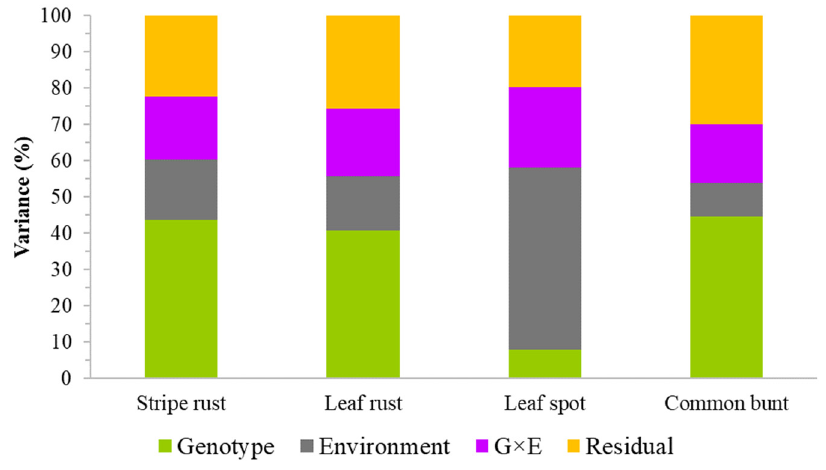
Figure 2. Partitioning of total variance into genotypes (G), environments (E), G × E interactions, and residual (error) variance components.